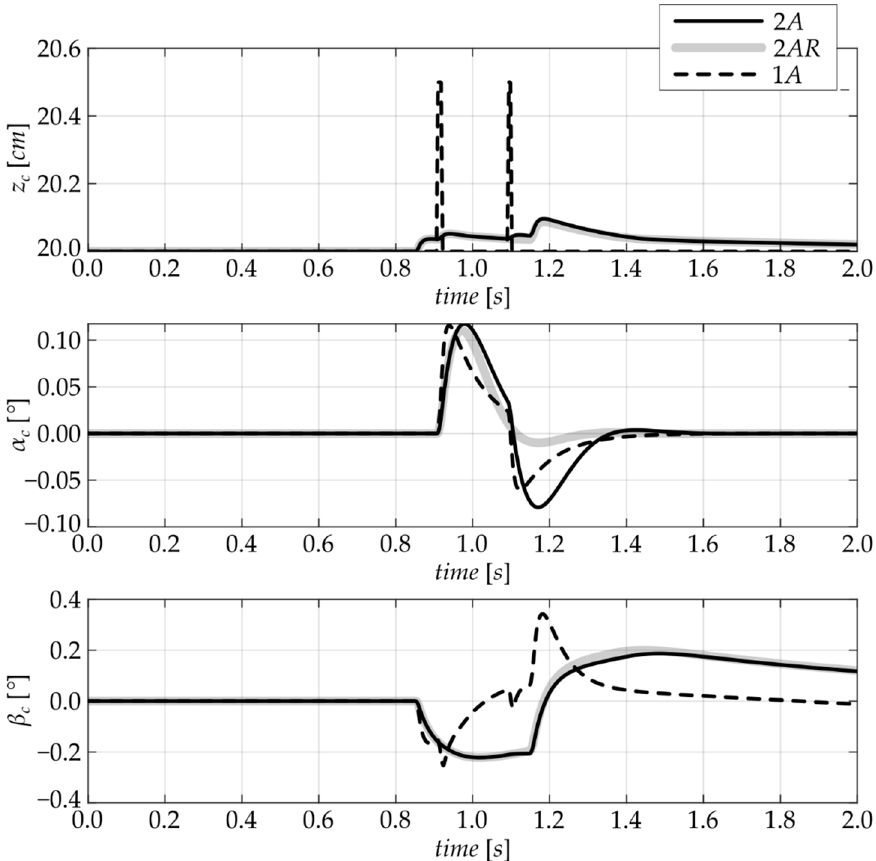
Figure 10. Use Case simulation 2: results.